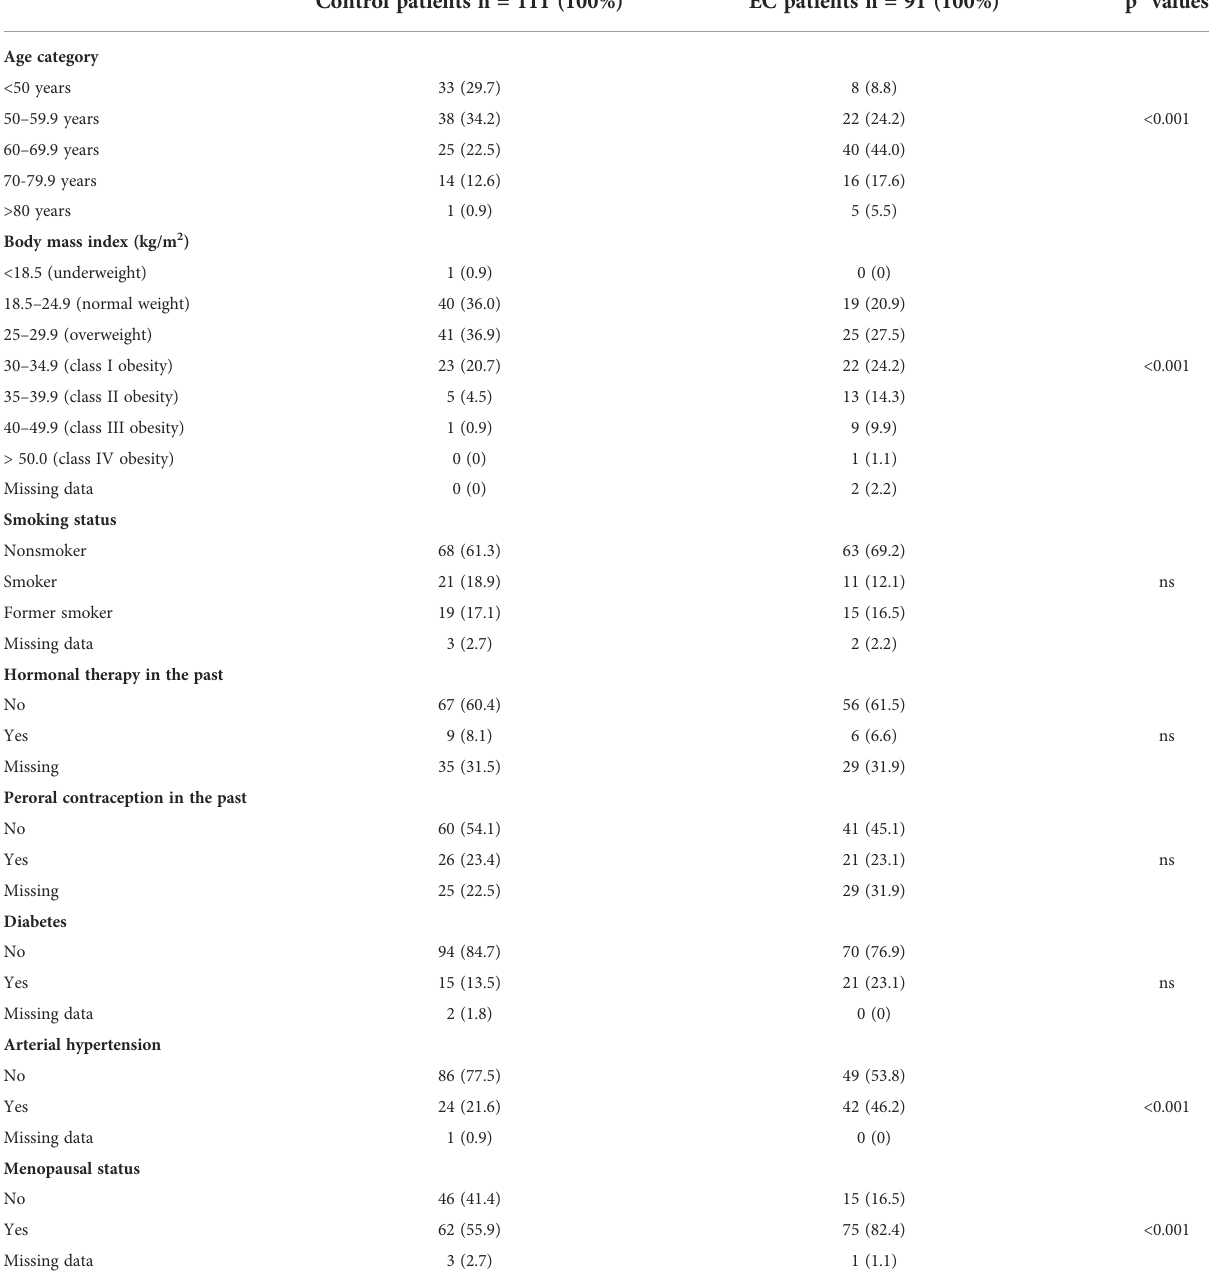
TABLE 1 Detailed clinical characteristics of the study